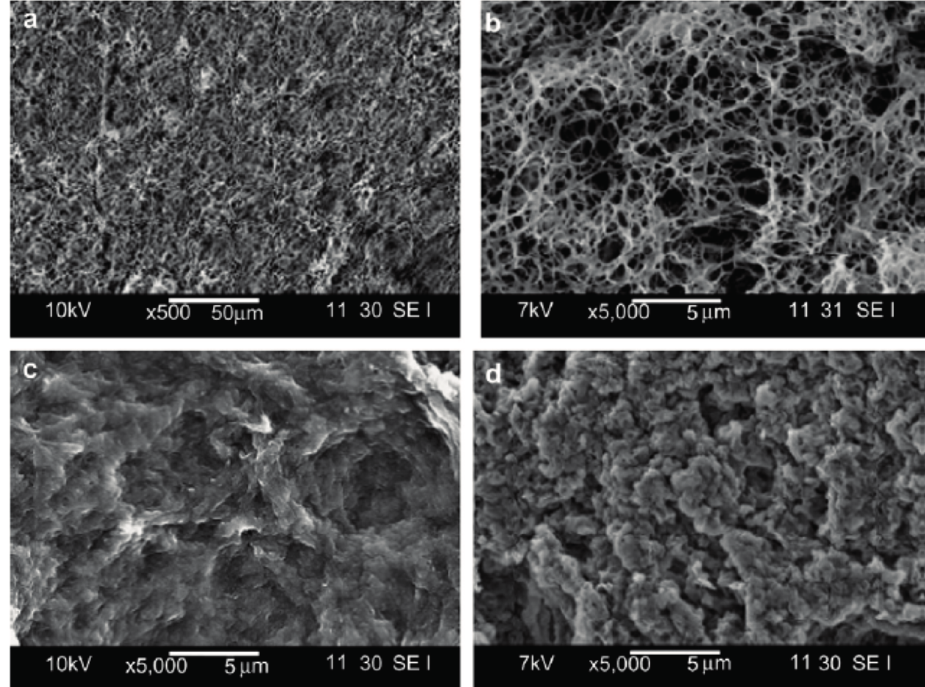
Figure 4. SEM studies of polyhydroxybutyrate (PHB) matrices formation under